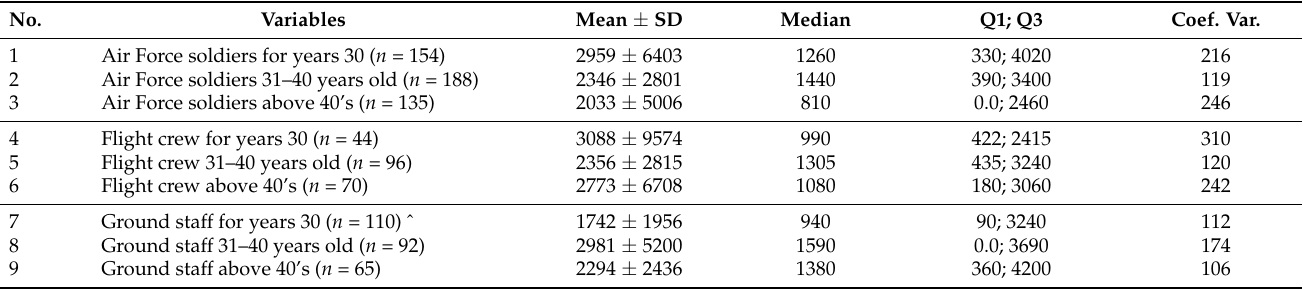
Table A4. Summary of total MET related to housework.